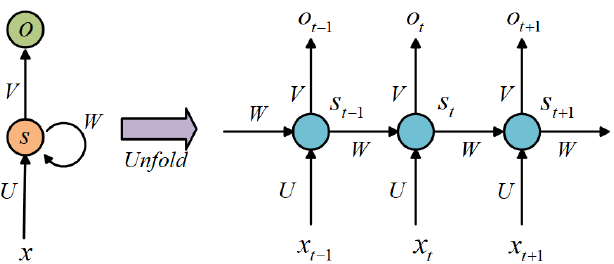
Figure 1. Basic RNN